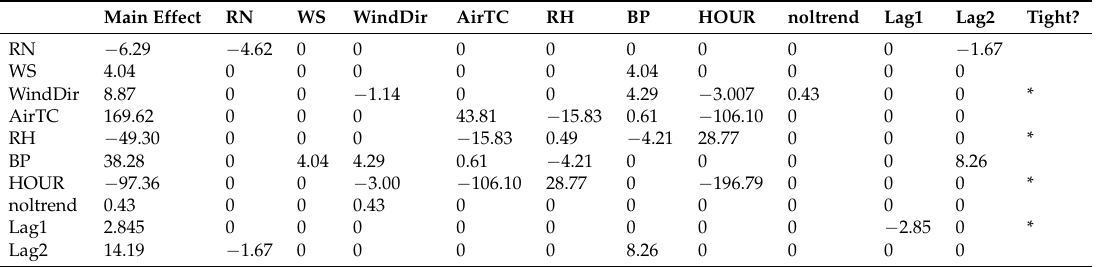
Table 2. Variables selected using Lasso via hierarchical interactions.